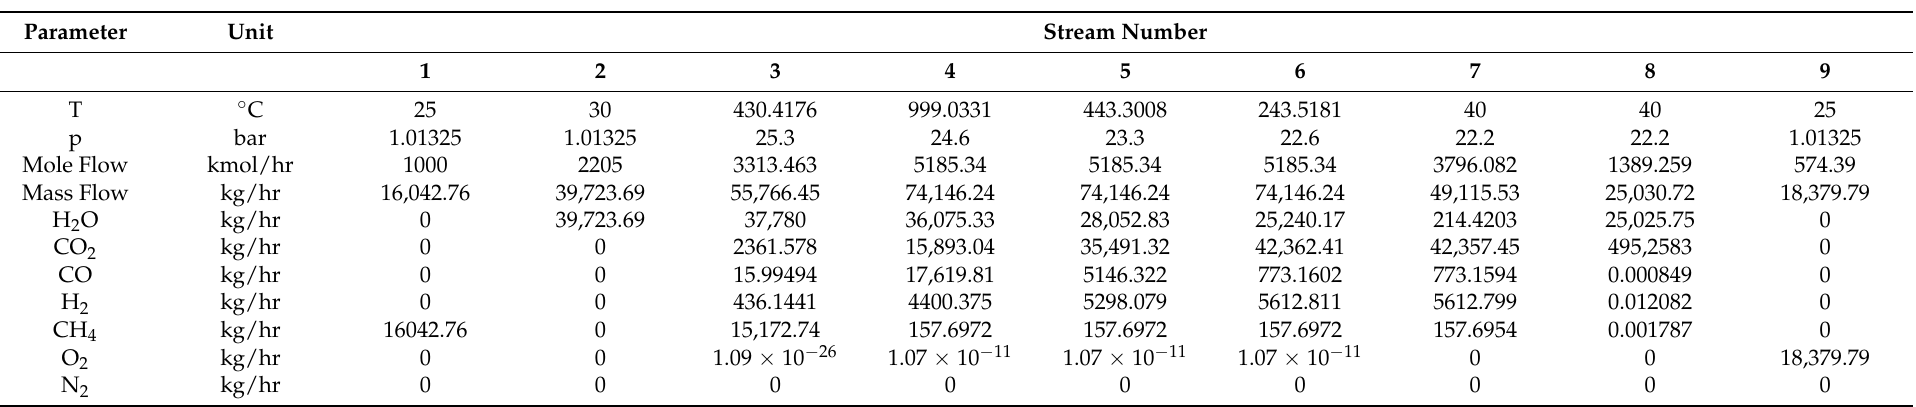
Table A2. Mass/mole flows in ATR process with temperature and pressure